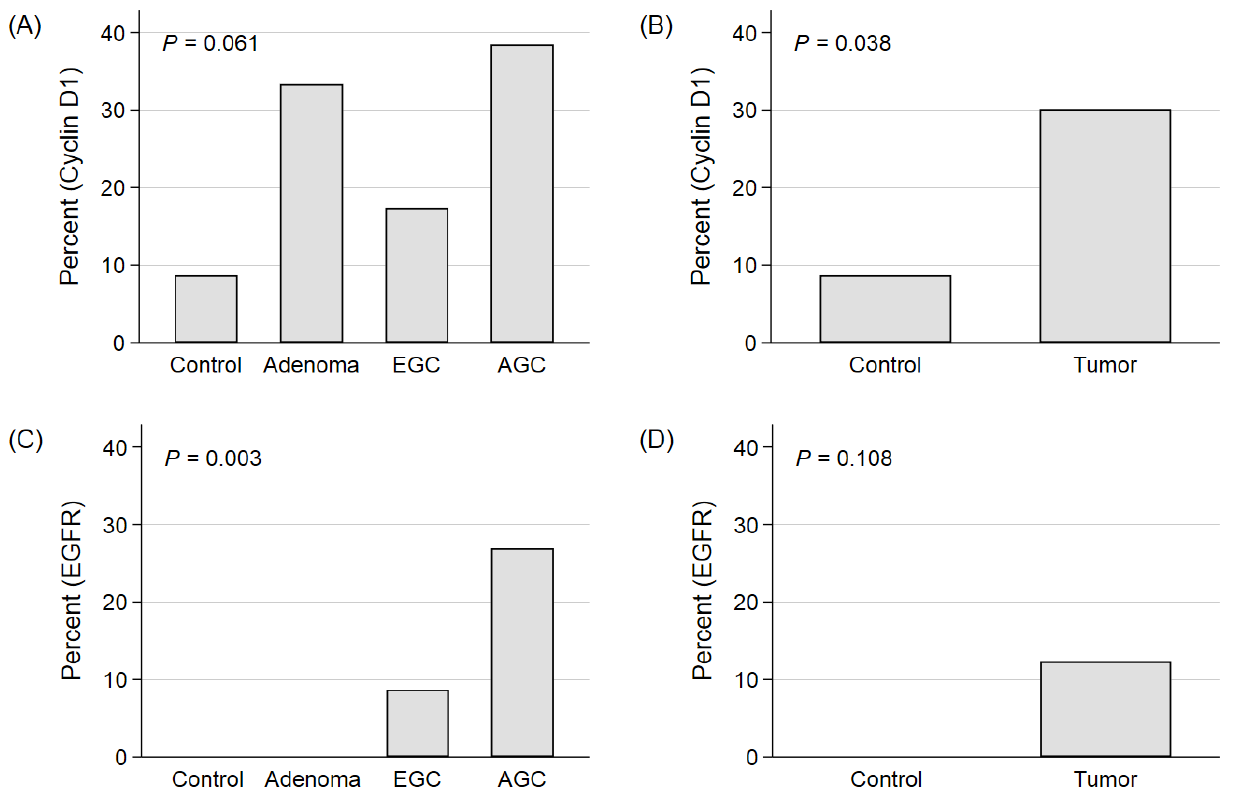
Figure 1. Expression of the biomarkers according to the progression of carcinogenesis. ( A , B ) Cyclin D1 and ( C , D ) EGFR.